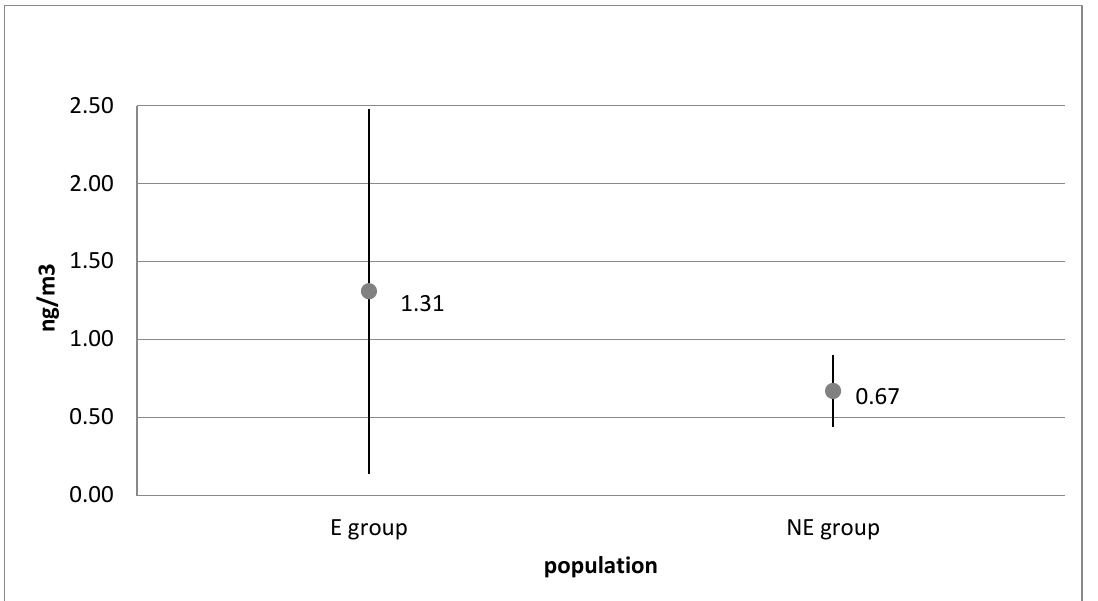
Figure 3. Residential PM 10 concentration from SWI, average and standard deviation. E vs. NE (ng / m 3